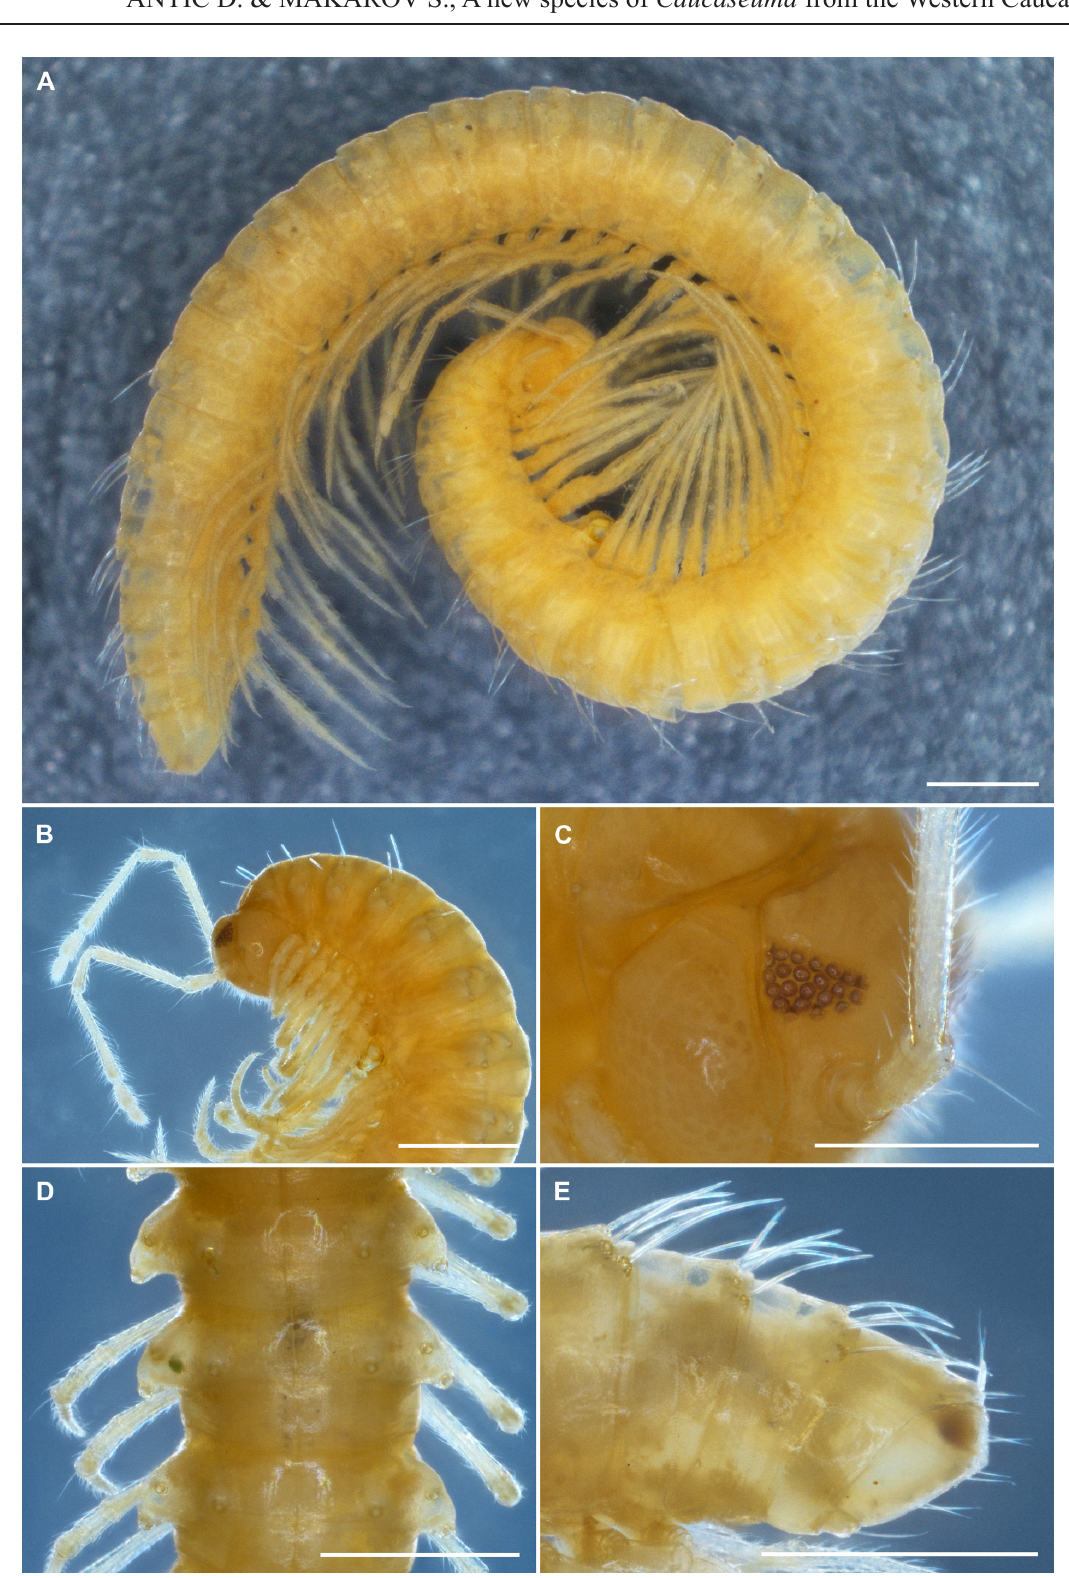
Fig. 2. Caucaseuma strasseri Antić sp. nov. A . Holotype, ♂ (ZMUM). B–E . Paratype, ♂ (IZB). A . Habitus, lateral view. B . Anterior part of the body, lateral view. C . Field with ommatidia, lateral view. D . Midbody rings, dorsal view. E . Telson, lateral view. Scale bars = 1